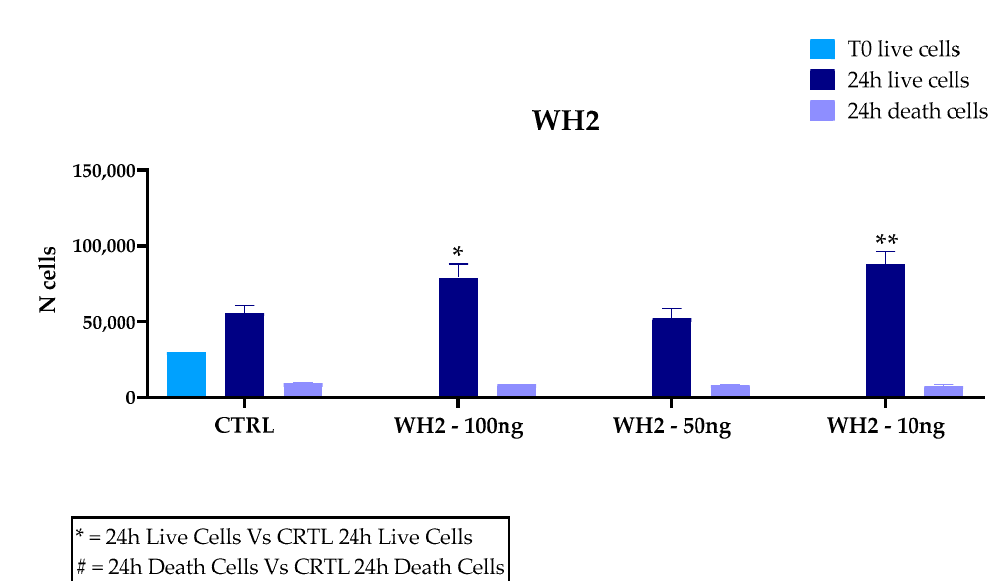
Figure 4. Trypan Blue assay for cytotoxicity of extracts on BV2 microglia cells. Cells were treated with 10, 50, or 100 ng/mL extracts of the husk (WH) of two supply chain. Data are reported as mean ± SD and normalized to the control of at least three independent experiments, and statistical analysis was reported using unpaired Student’s t -test. * p < 0.05; ** p < 0.01; *** p < 0.001; **** p < 0.0001; #### p < 0.0001.